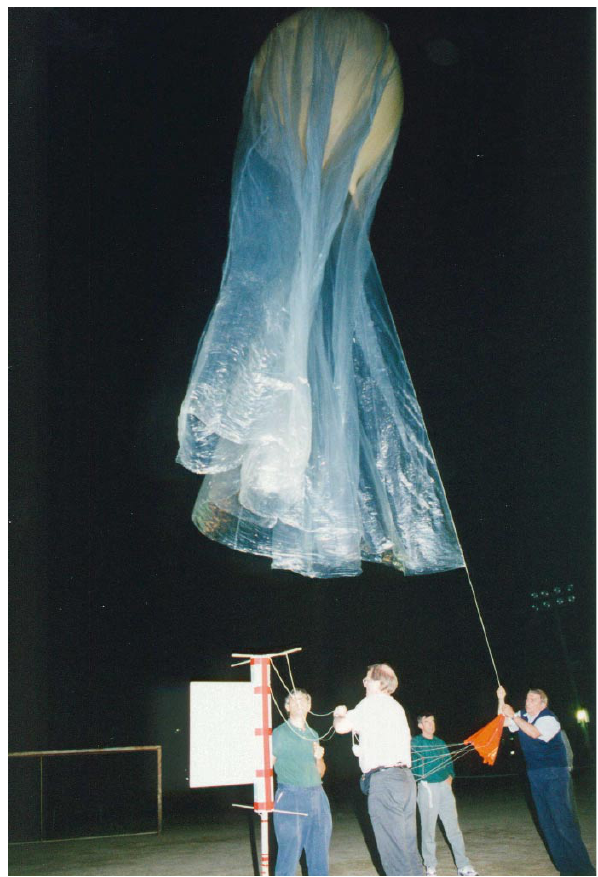
Fig. 17. Capsphere balloons used during the MUTSI experiment (May 2000) near the MU